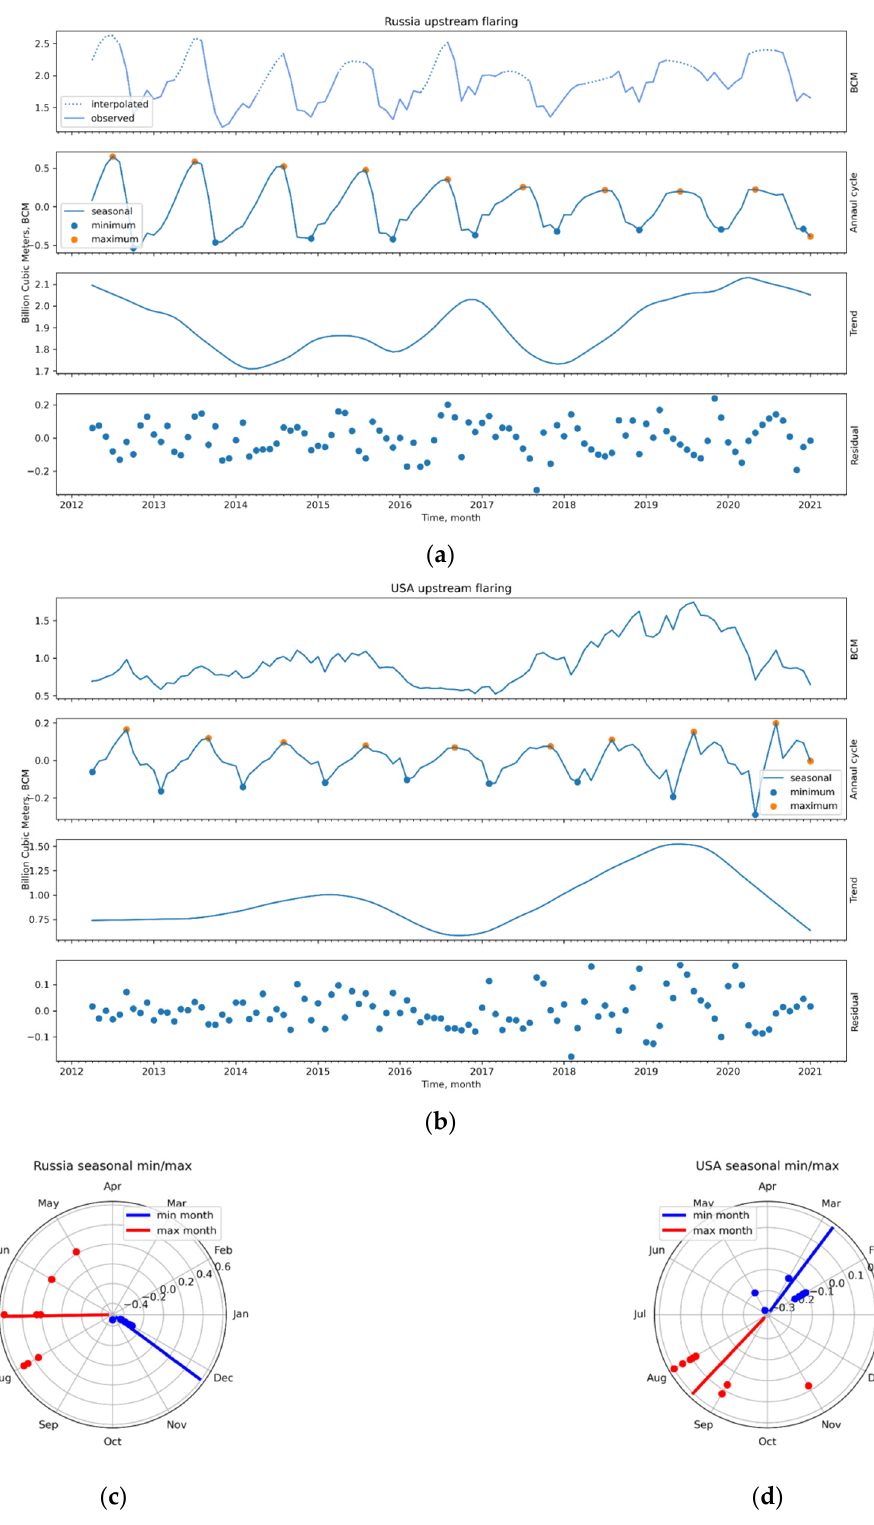
Figure 12. Comparison of VIIRS Nightfire-estimated monthly fluctuations in gas flaring in Russia ( a ) and the USA ( b ). The charts present, from top to bottom, monthly variations in flaring volume (in BCM) and its decomposition into the seasonal component, trend, and residuals. Summer data for Russia are interpolated (dashed line). ( c , d ) show the highest and lowest monthly flaring rates observed in Russia and USA, respectively (dots correspond to annual data, with line being the average date).